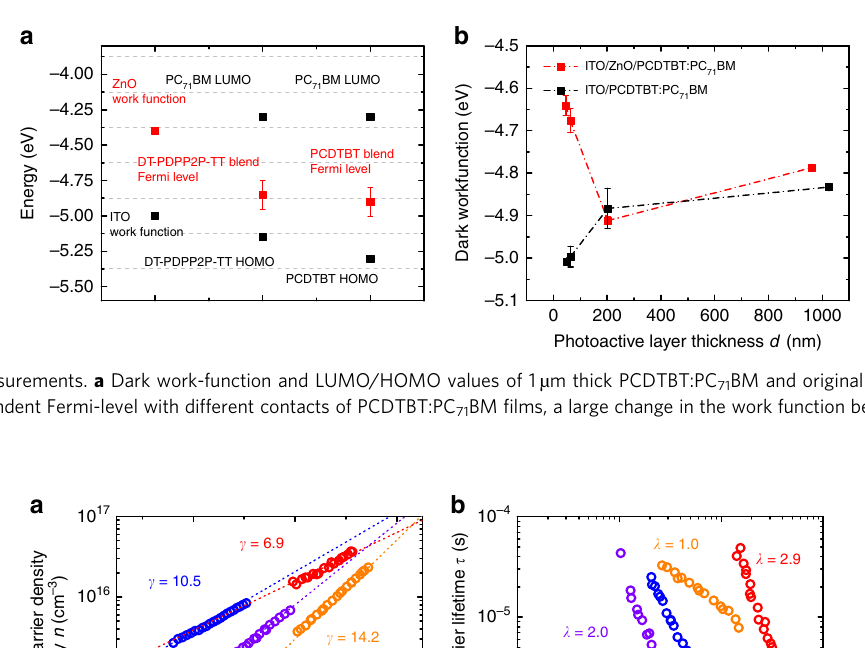
Fig. 6 Effects of tail states on energetics and recombination kinetics. A comparison of energetics and recombination kinetics between BTR:PC 71 BM, original DT-PDPP2T-TT:PC 71 BM, PCDTBT:PC 71 BM and puri fi ed DT-PDPP2T-TT:PC 71 BM blends. ( a ) shows the charge carrier density as a function of photo- induced open-circuit voltage in the four material blend systems, the slope γ indicates the density of tail states distribution against the energy; ( b ) shows the charge carrier lifetime as a function of charge carrier density, the slope λ associates with the recombination reaction order δ in a correlation of δ = λ +